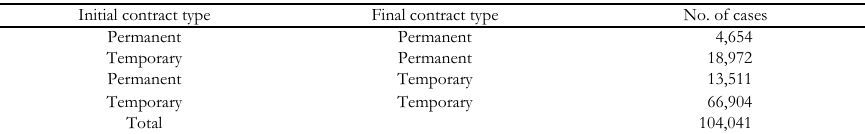
Workers by type of initial and final contract, within the Province of Bologna,